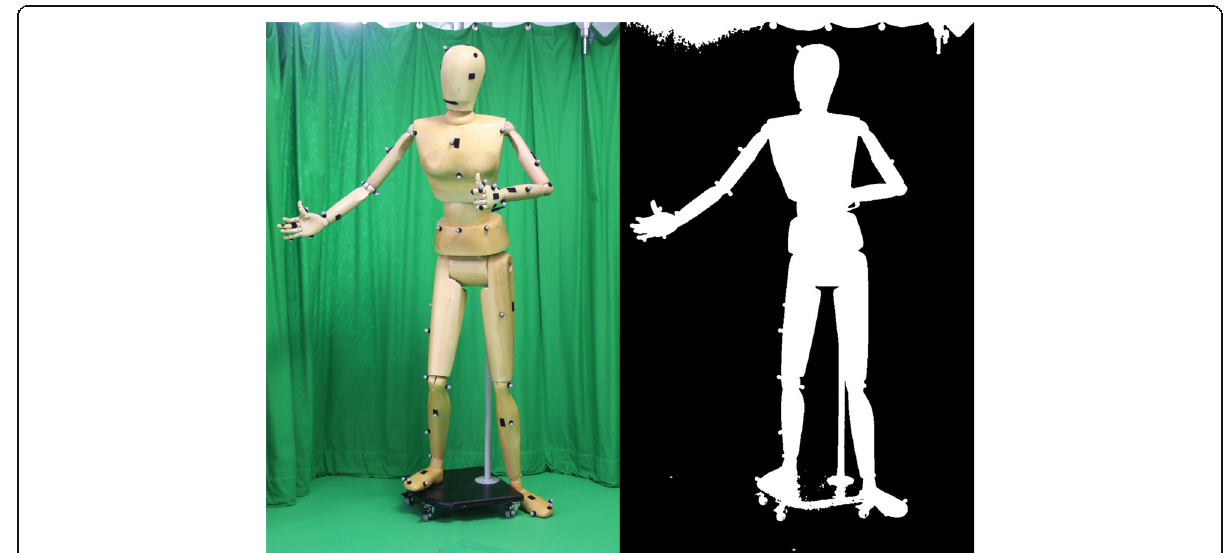
Fig. 6 Silhouette on the right from chroma keying the image on the left. When seen as only a silhouette, it is not possible to infer if the mannequin is facing towards or away from the